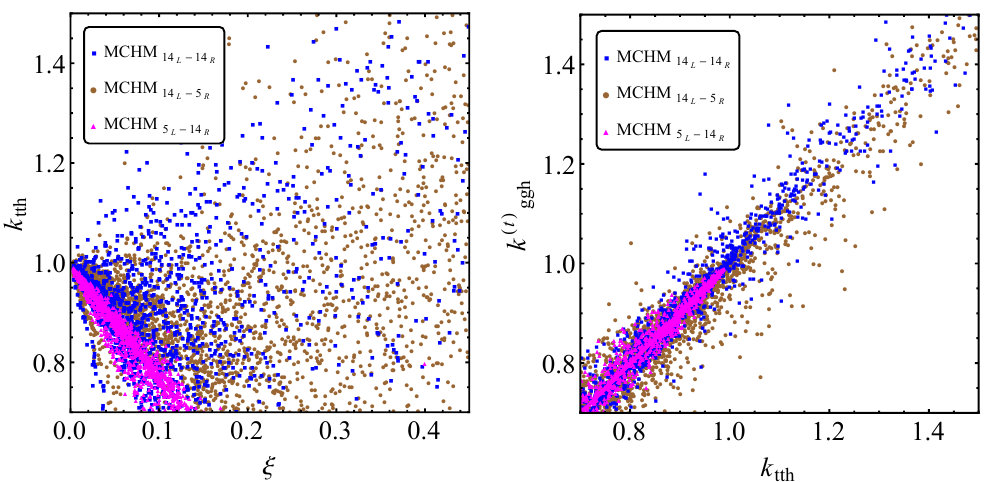
Figure 1. Results from the numerical analysis for MCHM 14 and MCHM 5 (magenta) are shown. In the left panel k L (cid:0) 14 R right panel we show the correlation between k ( t ) vary the strong couplings g i and g (cid:26) in the range [1 ; 2 (cid:25) ] and (cid:21) L;R shown in the plots satisfy the phenomenological constraints given in eqs.